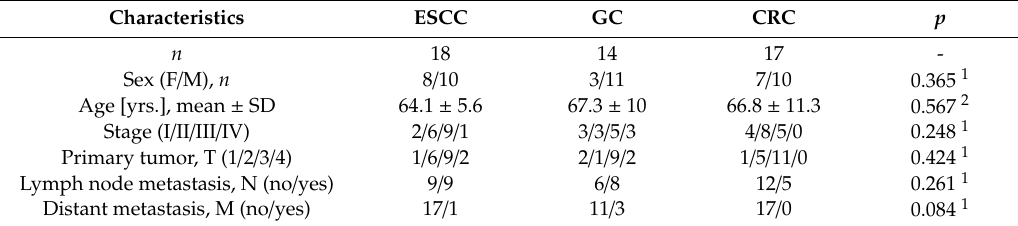
Table 1. Characteristics of study population for analysis of local interleukin expression at mRNA level.